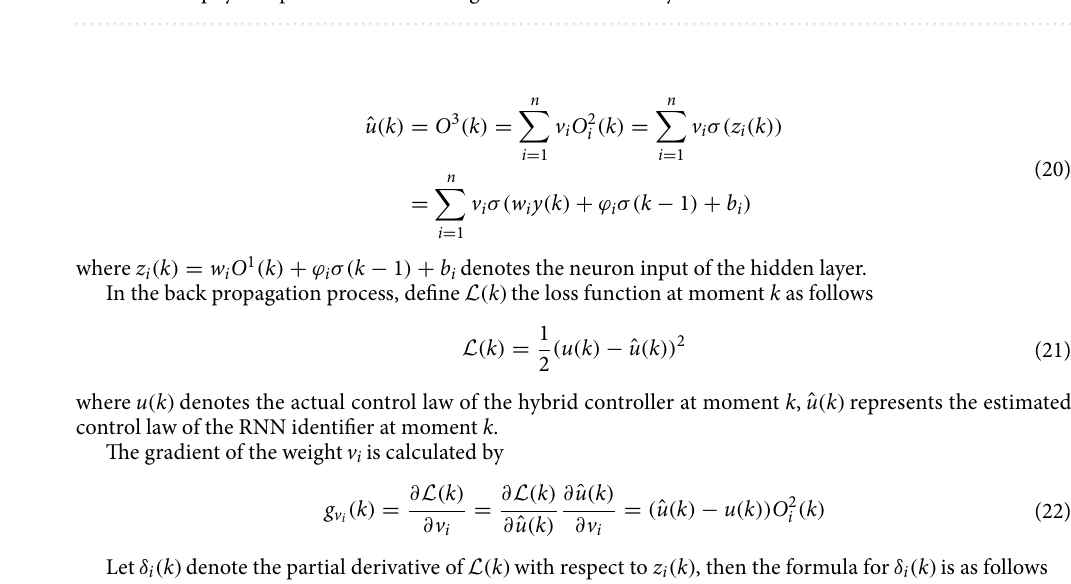
Table 1. The physical parameters of the magnetic levitation ball